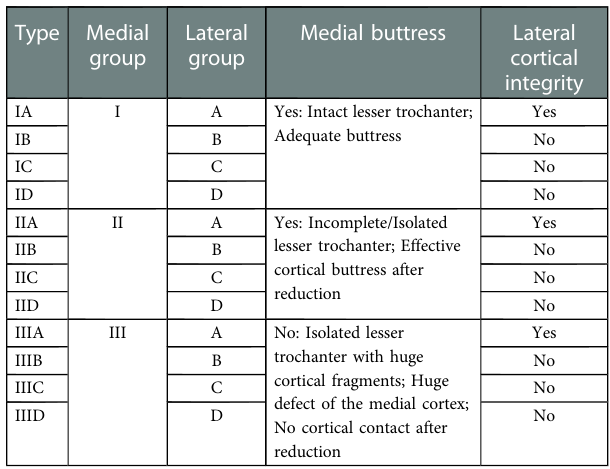
TABLE 1 The new classi fi